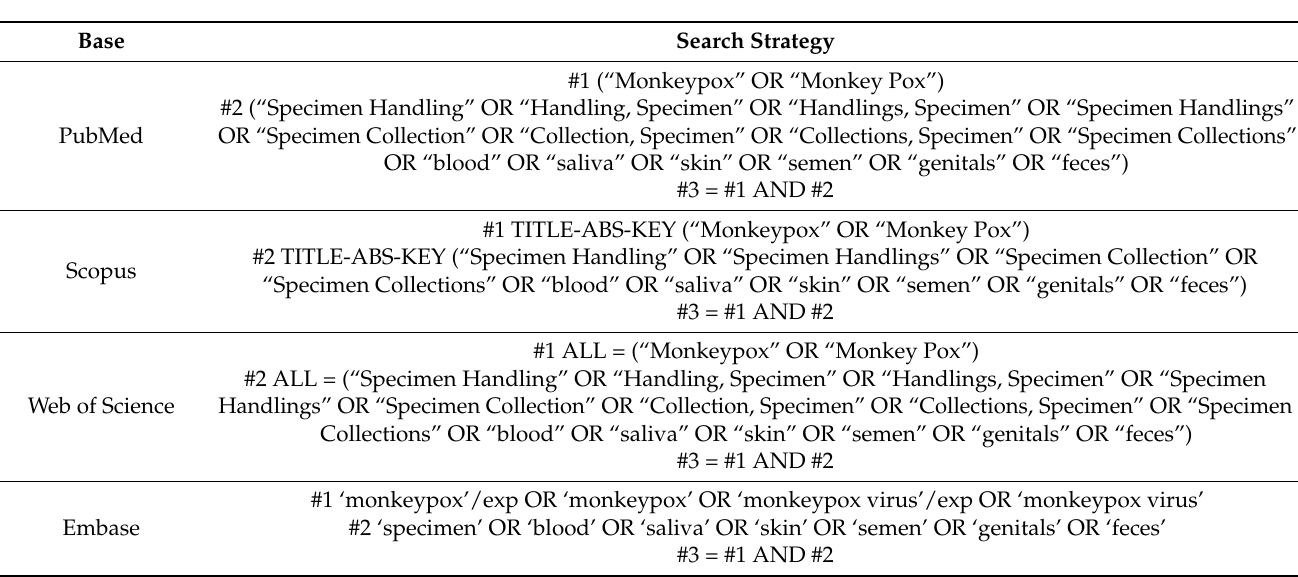
Table 1. Bibliographic search